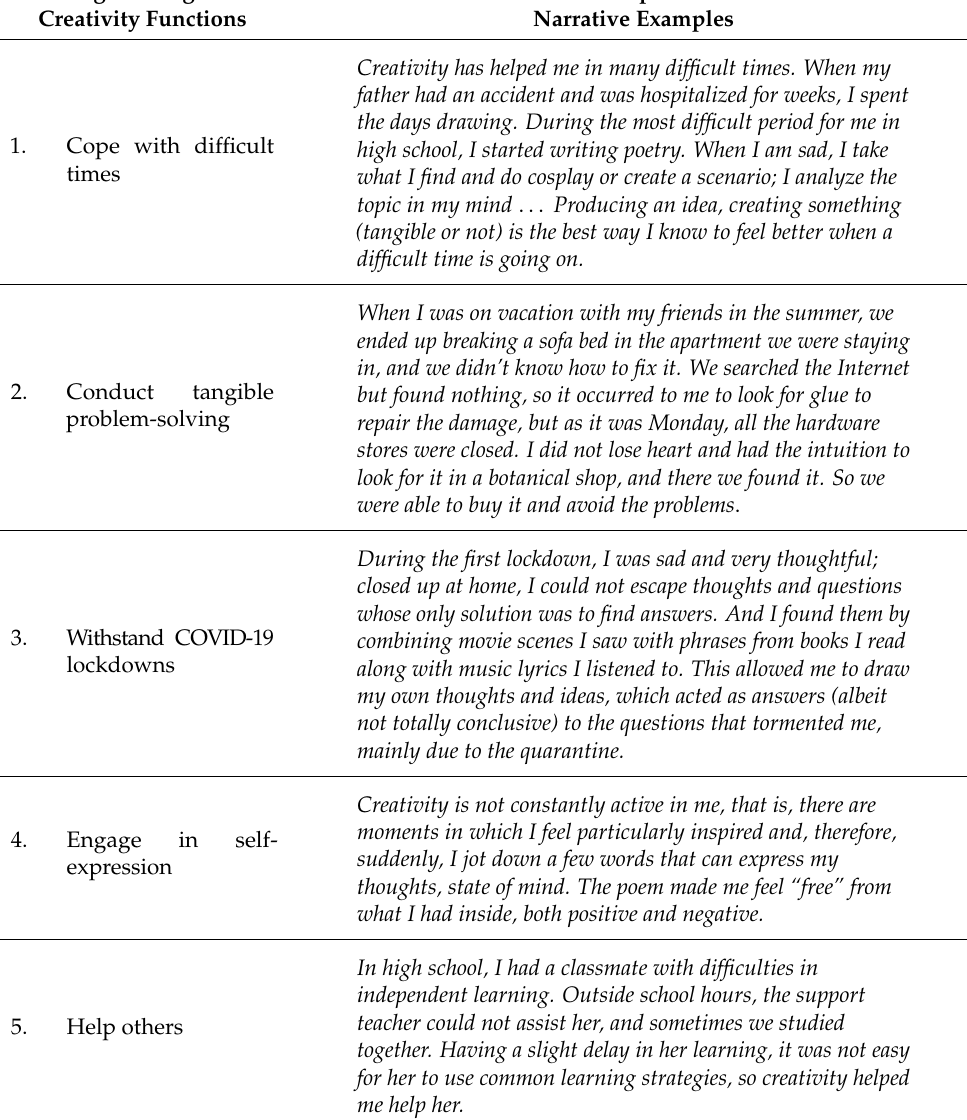
Table 2. Creativity as a resource: Descriptive